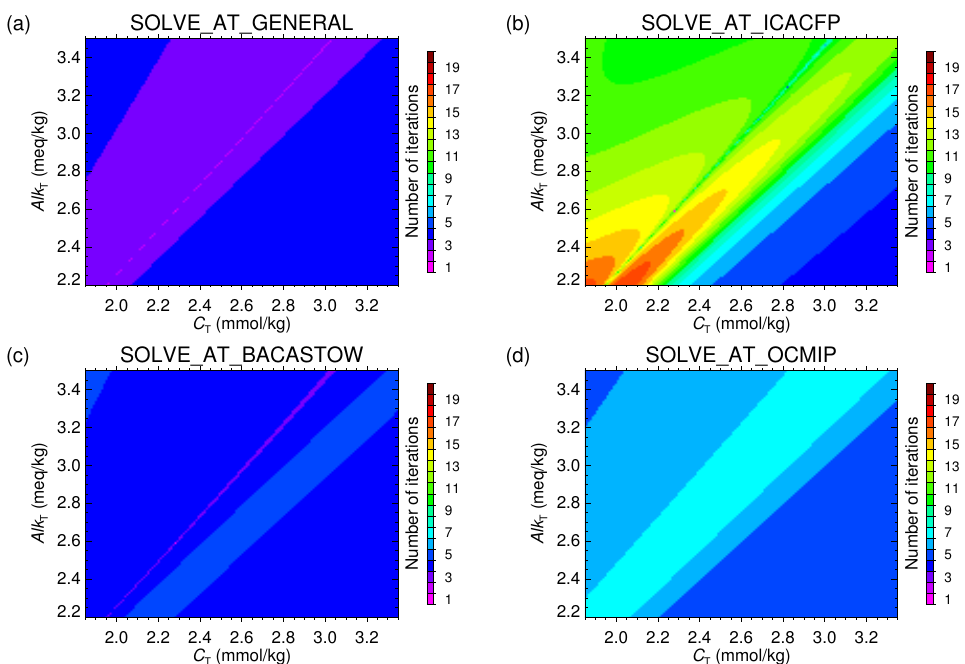
Fig. 2. Number of iterations required by (a) general , (b) icacfp , (c) bacastow with secant iterations on [H + ] and (d) ocmip , each one using the cubic-based initialization procedure to solve test case SW2. Applied convergence criterion: | H n + 1 − H n | /H n < 10 − 8